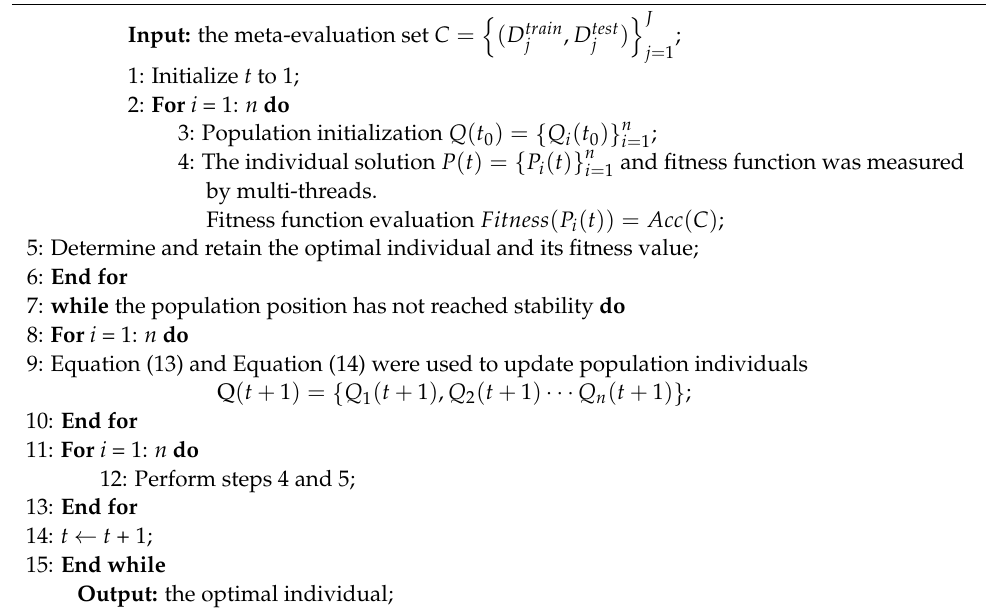
Algorithm 1 Adaptive feature fusion and weight optimization algorithm